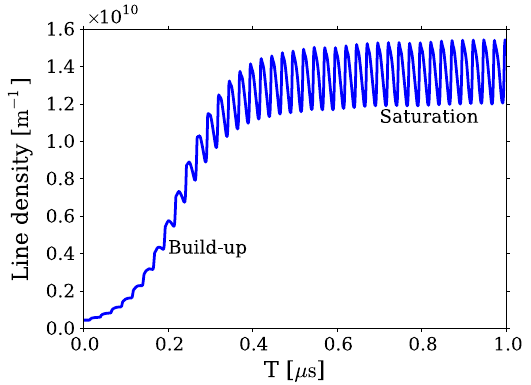
FIG. 1. Electron cloud buildup in the presence of an external dipole magnetic field. One can see the initial exponential phase and the saturation. The latter is studied in this paper. N ¼ 1 . 4 and δ max